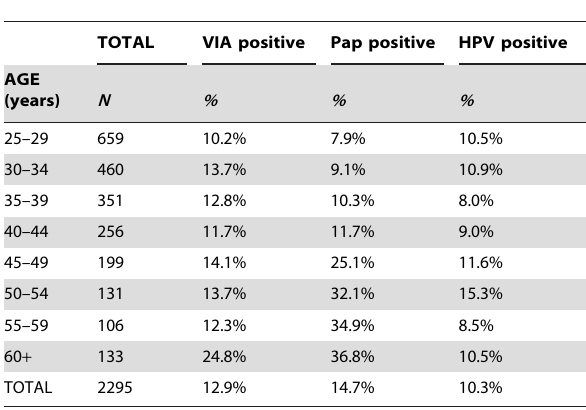
Table 2. Age-specific positive screening test